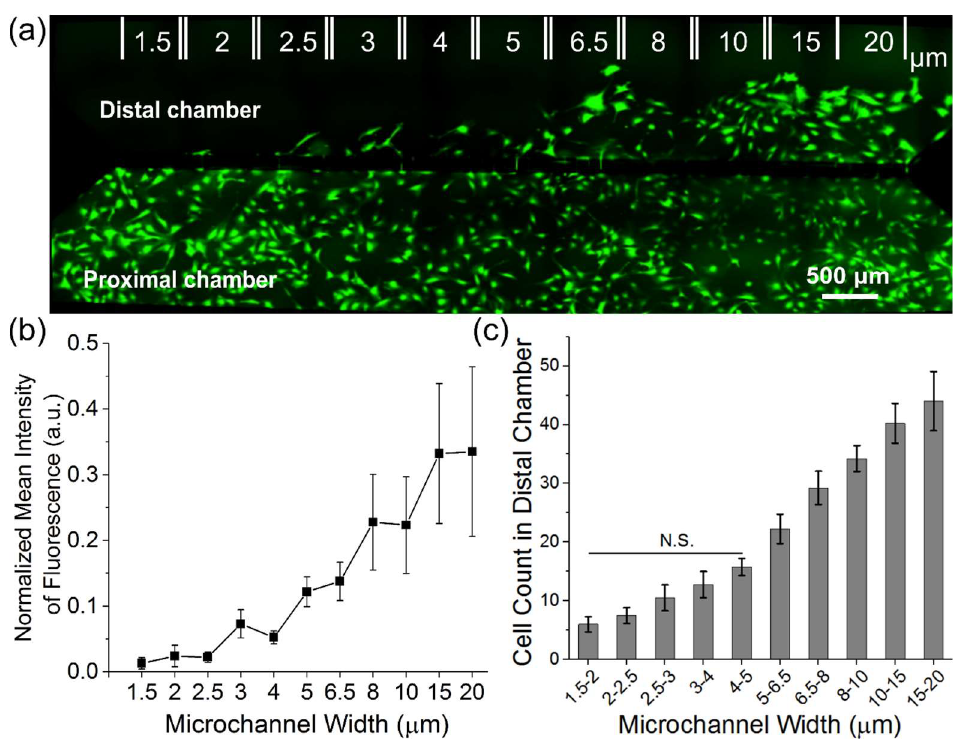
Figure 3. Migration behavior of primary myoblasts is dependent on the width of microchannels. ( a ) Representative fluorescent image of cells stained with Calcein AM in the proximal and distal chamber 48 h after seeding. The device consists of microchannel length 100 µm and variable widths (1.5–20 µm) with 6 repeating microchannels per width. ( b ) Normalized mean intensity of fluorescence in the distal chamber taken for each width from 1.5–20 µm sections. The mean intensity of fluorescence was normalized to the proximal chamber. ( c ) Quantification of the number of cells in the distal chamber after 48 h from 1.5–20 µm sections. To determine statistically significant differences in the cell count in the distal chamber as a function of microchannel width, a one-way ANOVA with a post hoc Tukey test was performed. Error bars represent standard error of the mean (SEM).